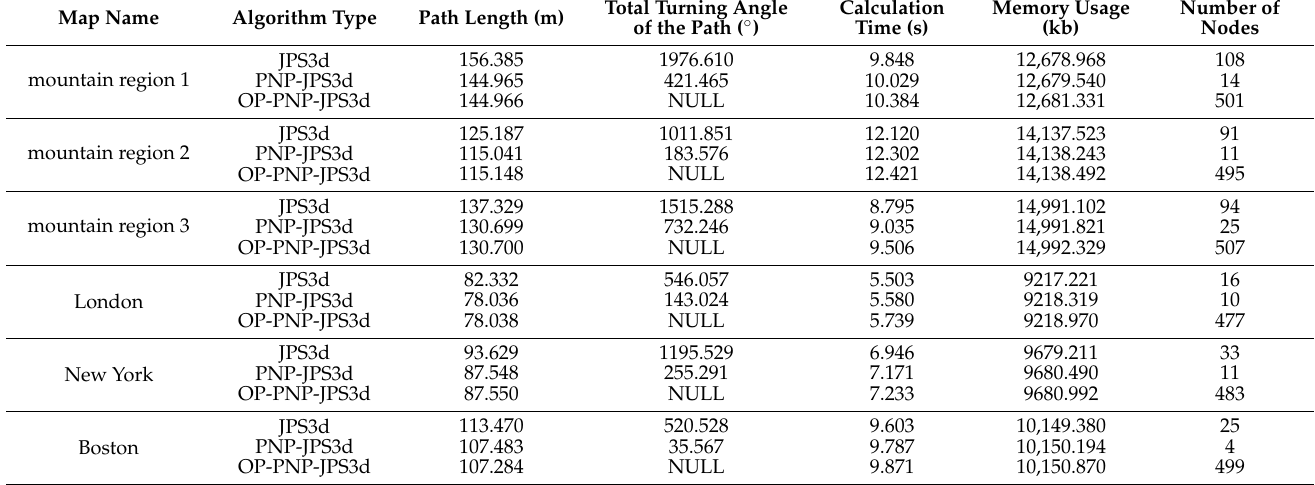
Table 1. Map information selected for the